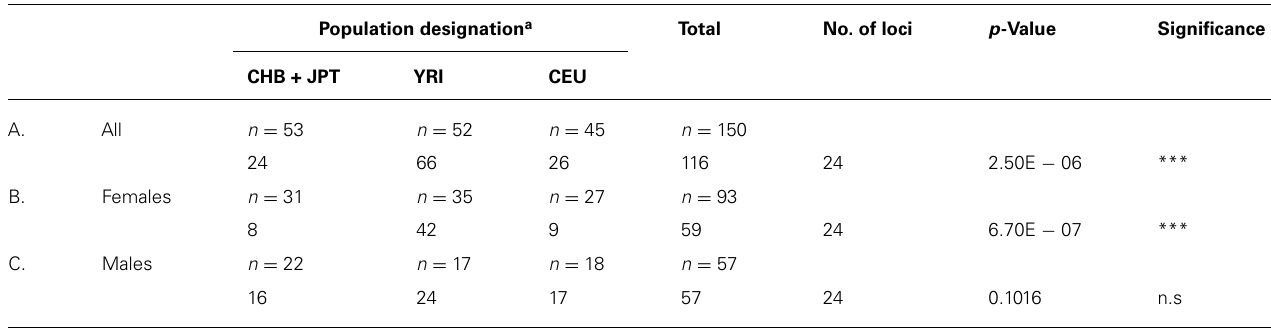
Table 7 | Between-population sex bias in the CNV numbers among 24 pseudogenes of OR7E subfamily that showed strictly one-copy